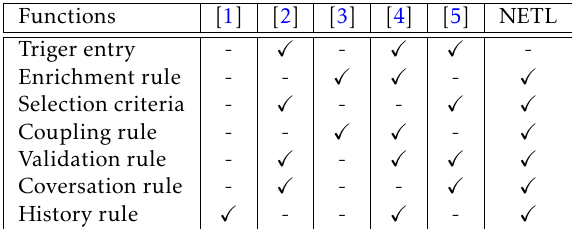
Table 1. Comparative Analysis of recent ETL models based on Data analysis, preperation and report